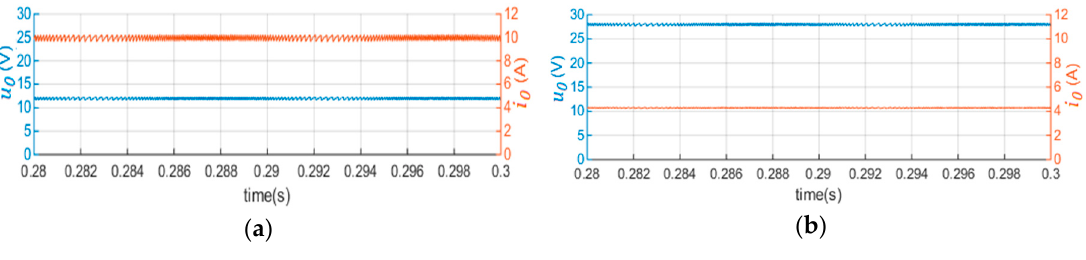
= 12 V; ( b ) u ref = 28 V. Figure 4. Simulation waveforms for different voltage references: ( a ) 𝑢 (cid:2868)(cid:3045)(cid:3032)(cid:3033) = 12 V; ( b ) 𝑢 (cid:2868)(cid:3045)(cid:3032)(cid:3033) = 28 V. 0 0